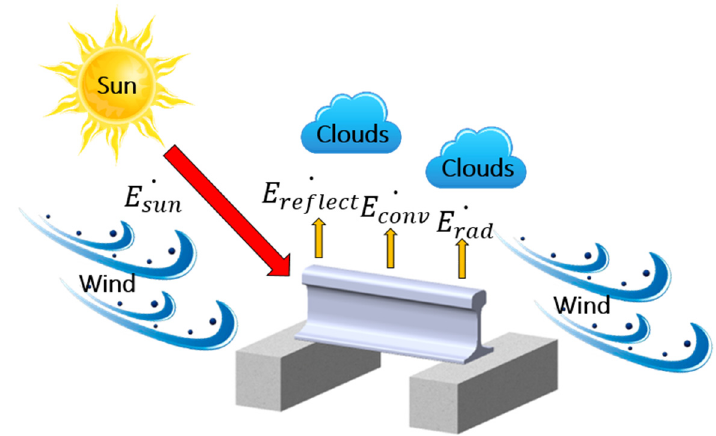
Figure 2. Thermal environment around the rail.